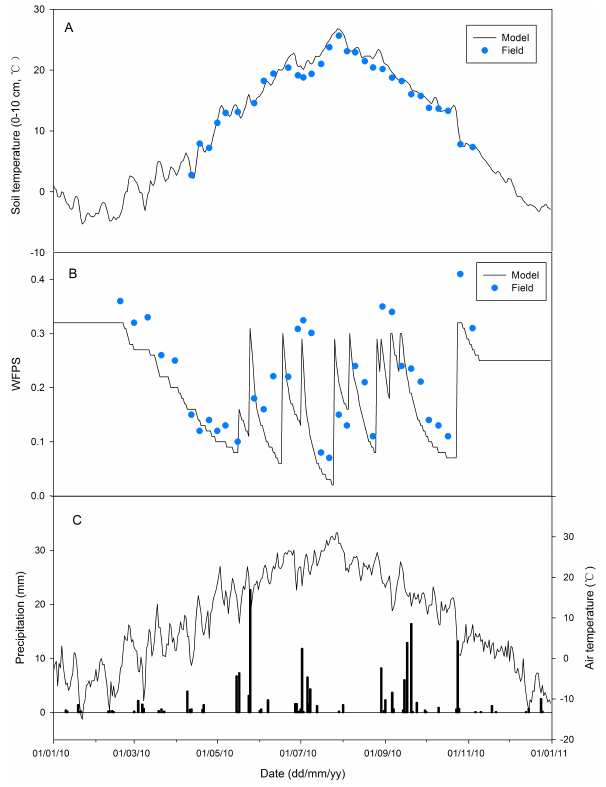
Fig. 2. Comparison of observed and modeled soil temperature be- tween 0–10cm (A) , water-filled pore (WFPS) between 0–10cm (B) , and climatological measurements (C) .